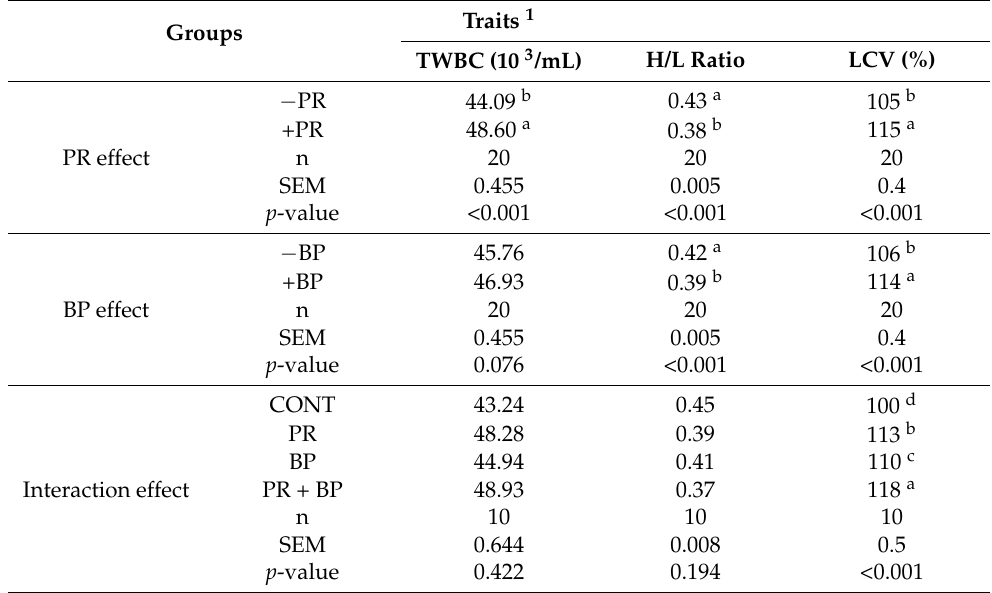
Table 5. Effect of propolis (PR), bee pollen (BP), and their interaction (PR + BP) on leukocytes count, differentiation, and viability of broiler